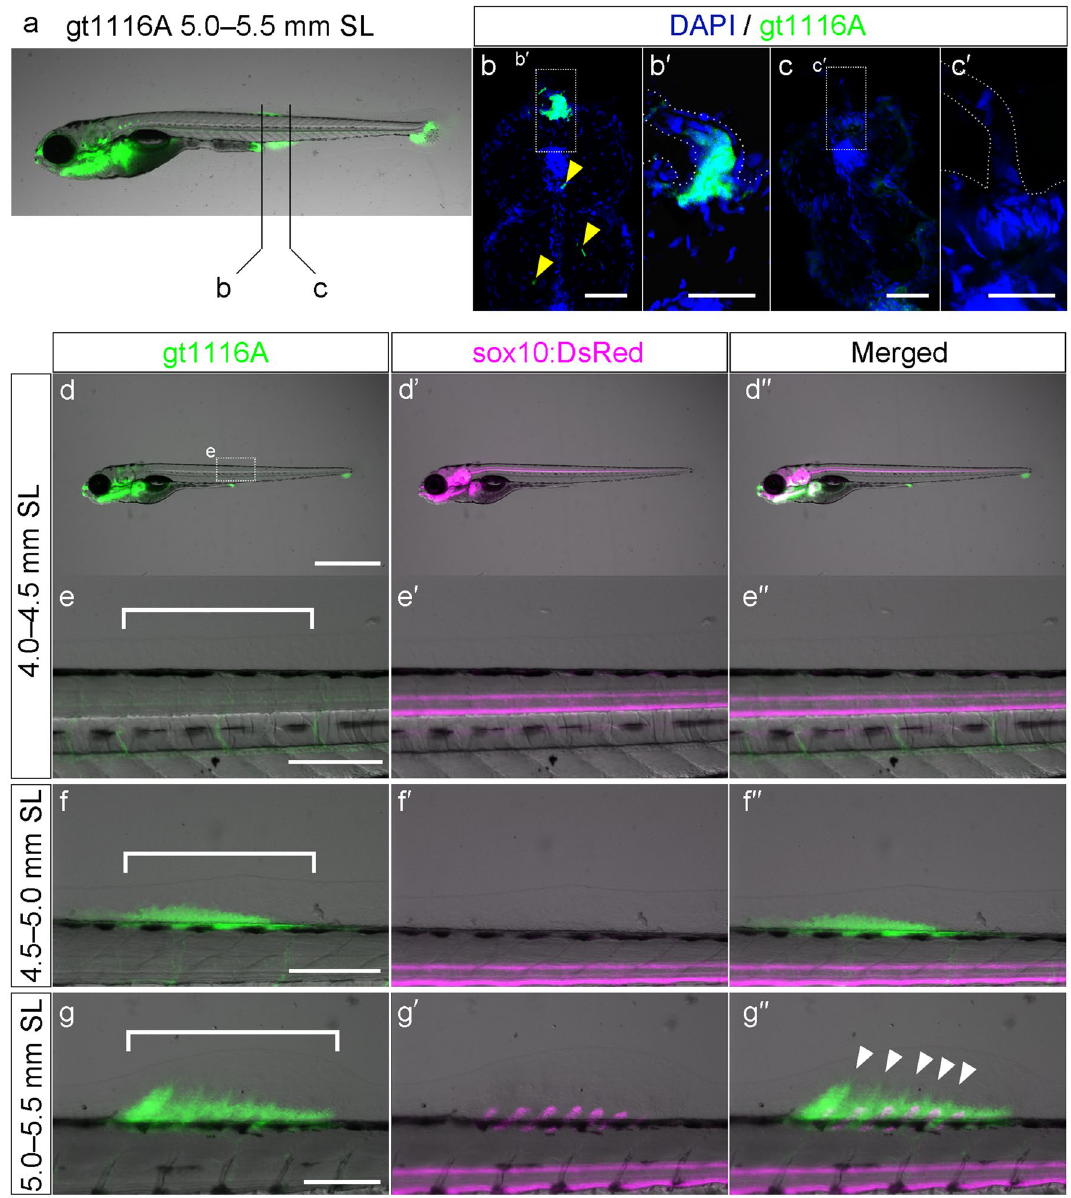
Figure 4. Expression pattern of UAS:EGFP in the gt1116A line and sox10:DsRed in the LMFF of double- transgenic zebrafish. ( a – c’ ) Expression pattern of UAS:EGFP of the gt1116A line in the LMFF at 5.0–5.5 mm SL. Black lines in ( a ) indicate levels of the section shown in ( b,c ). Yellow arrowheads in ( b ) indicate blood vessels. Expression pattern of UAS:EGFP of the gt1116A line and sox10:DsRed in the LMFF of double-transgenic fish at 4.0–4.5 mm SL ( d – e” ), at 4.5–5.0 mm SL ( f – f” ), and 5.0–5.5 mm SL ( g – g” ). White brackets in ( e,f,g ) indicate future sites of the dorsal fins. White arrowheads in ( g” ) indicate distal expansion of the EGFP-positive mesenchymal cell population. Scale bars in ( b – c’ ) and those in ( d,e,f,g ) indicate 50 μm and 200 μm,